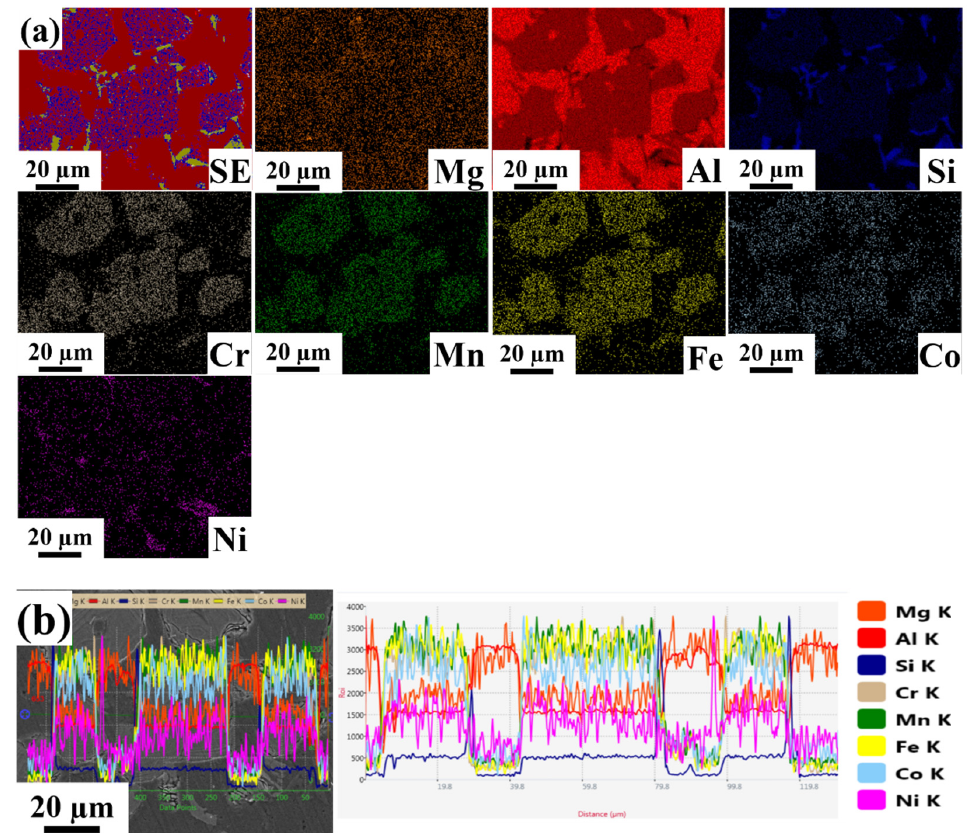
Figure 6. Energy dispersive spectroscopy images of LM25–10 wt.% HEA. ( a ) Elemental mapping images. ( b ) Line scan image.